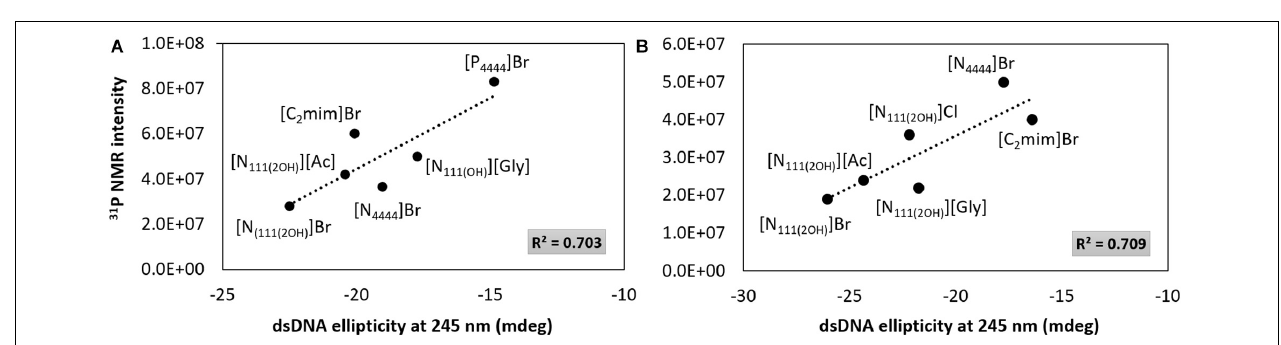
FIGURE 6 | 31 P NMR intensity peaks of DNA as a function of dsDNA ellipticity at 245 nm. (A) IL at 5 wt%; (B) IL at 30 wt%.